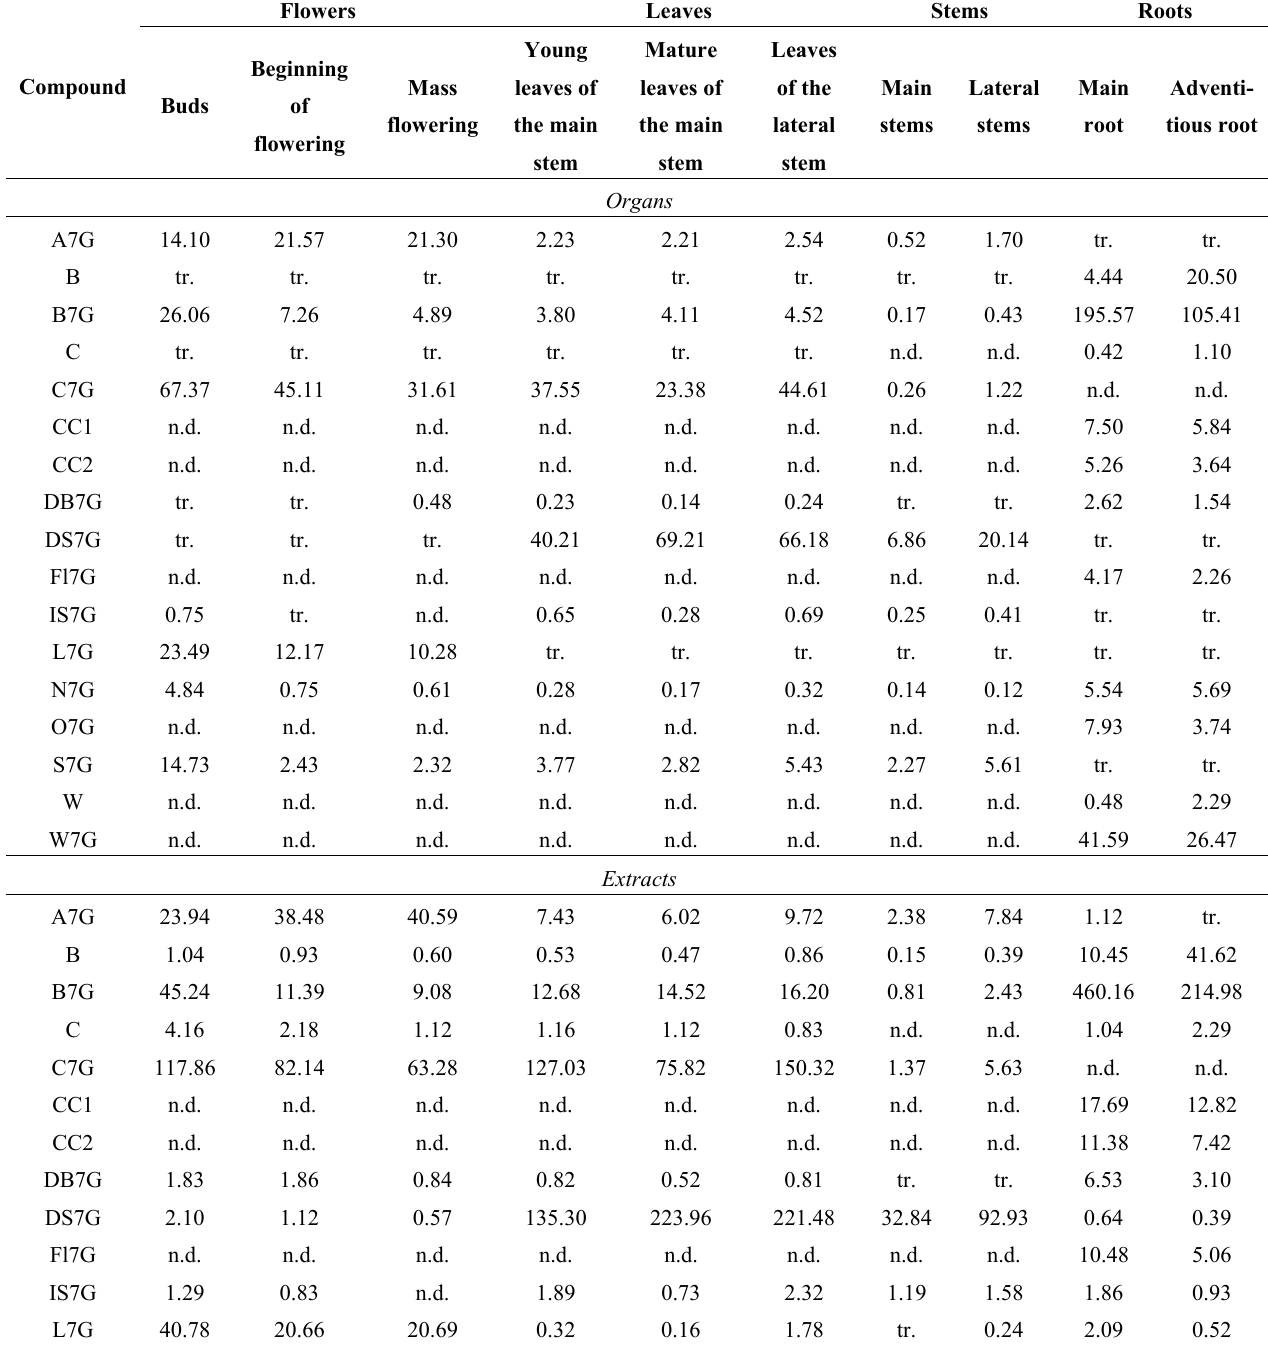
Table 2. Content of phenolic compounds in organs and extracts of S. baicalensis (mg · g − 1 of dry plant/extract